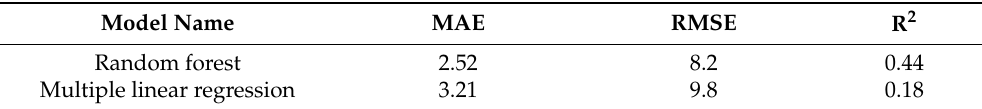
Table 6. Comparison of model